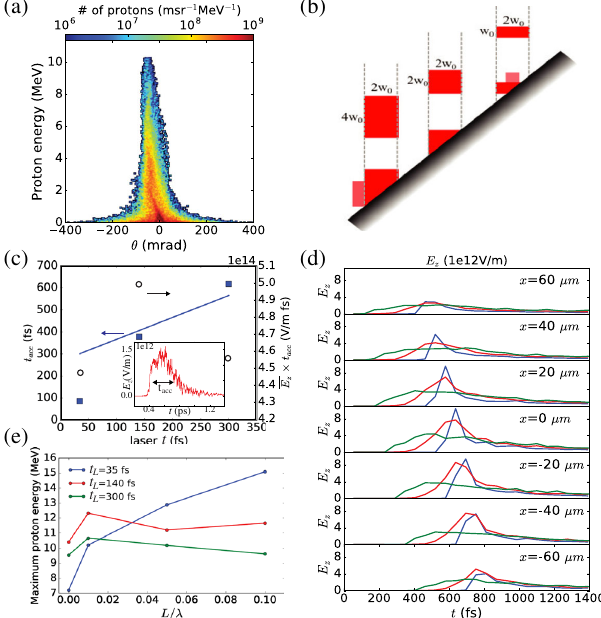
FIG. 4. (a) Simulated Energy vs angle distribution of protons in logarithmic color scales. (b) Sweeping effect shown schemati- cally for three different laser pulse lengths as indicated in the figure. (c) Acceleration time ( t ) defined as the 1 =e duration of FIG. 5. (a) Evolution of longitudinal electric field E z and acc E electron temperature T e at three different times during the z acting on the protons with highest energy (see inset) as a function of a laser pulse duration (blue squares). Estimated interaction with L ¼ 0 . 01 λ L , shown for three laser pulse duration interaction time 2 w 0 =c þ t L (blue line). Impulse experience by in (a) 30 fs, (b) 140 fs and (c) 300 fs. The time t ¼ 636 fs ¯ E t a proton, electric field (black circles). (d) E z as a corresponds to the peak time of the spatiotemporal of the laser z × acc function of simulation time at different transversal locations x as pulse at the front side of the target. indicated in the figure for laser pulse durations of 30 fs (blue), 140 fs (red) and 300 fs (green). (e) Maximum proton energy for laser pulse durations of 30 fs (blue), 140 fs (red) and 300 fs (green) as a function of L